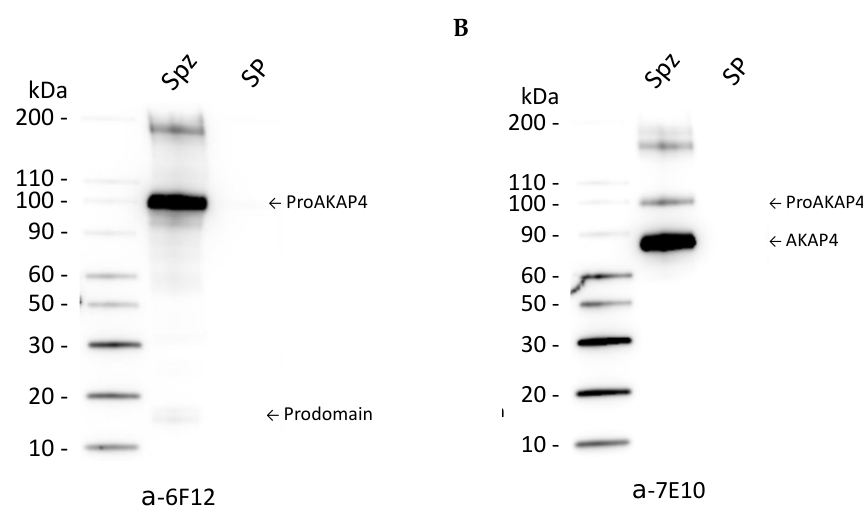
Figure 1. ( A ) Western blot analysis of ProAKAP4 and AKAP4 expression in post-thawed isolated spermatozoa (SPZ) in post-thawed cryopreservative without spermatozoa (SP). ProAKAP4 and the prodomain (indicated by arrows) were detected in the spermatozoa (SPZ) lane at 100 and 18 kDa but not in the extender (SP) diluted with the cryopreservative (SP) with the 6F12 mouse monoclonal purified antibody. ( B ) Both proAKAP4 and AKAP4 were detected at 100 and 82 kDa with the 7E10 mouse monoclonal purified antibody. No labelling was observed in the lane with extender with cryopreservative without spermatozoa (SP lanes). Apparent molecular weights were indicated on the left of the SDS-PAGE lanes and determined using calibrated molecular weight markers. The whole Western blot figure in the Supplementary Figure